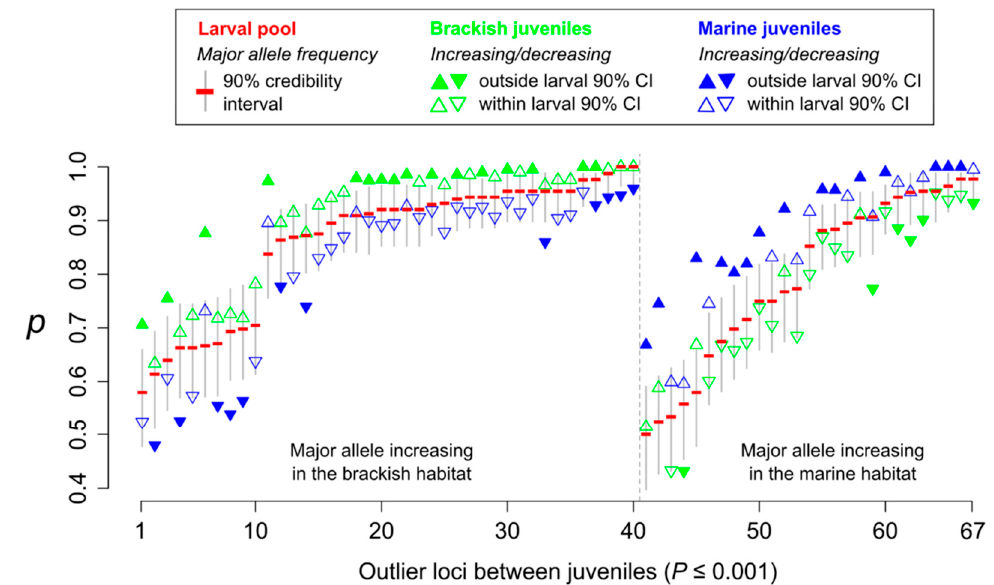
Figure 2. Allele frequency changes at 67 outlier loci detected between brackish and marine juveniles with the single generation selection (SGS) test, using a nominal significance threshold of 10 − 3 . For each locus, allele frequency of the major allele ( p ) is indicated in the larval pool (red, with the 90% credibility interval in grey), brackish juveniles (green triangles) and marine juveniles (blue triangles). Upper triangles show increased allele frequency compared to the larval pool; lower triangles show decreased allele frequency compared to the larval pool.